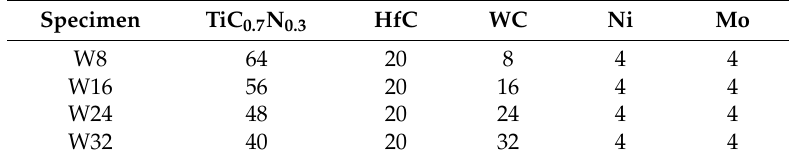
Table 1. Composition ratios of TiC 0.7 N 0.3 -HfC-WC-Ni-Mo cermets (wt %).